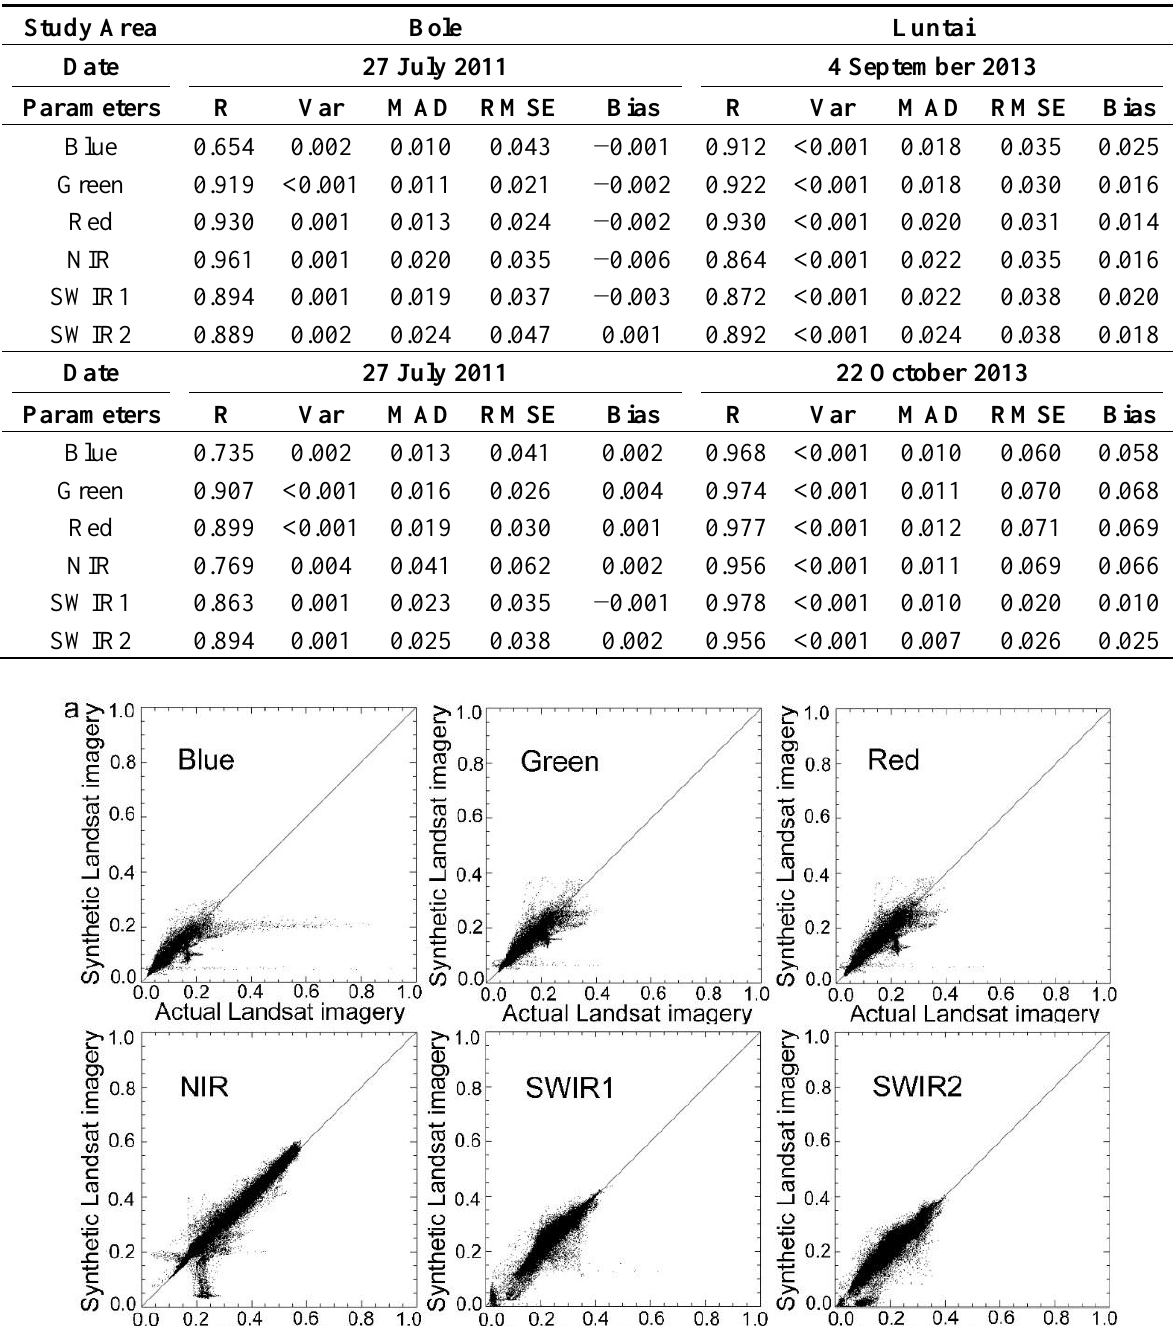
Table 6. Results of correlation analysis between synthetic and actual Landsat imageries by using the spatial and temporal data fusion approach (STDFA).